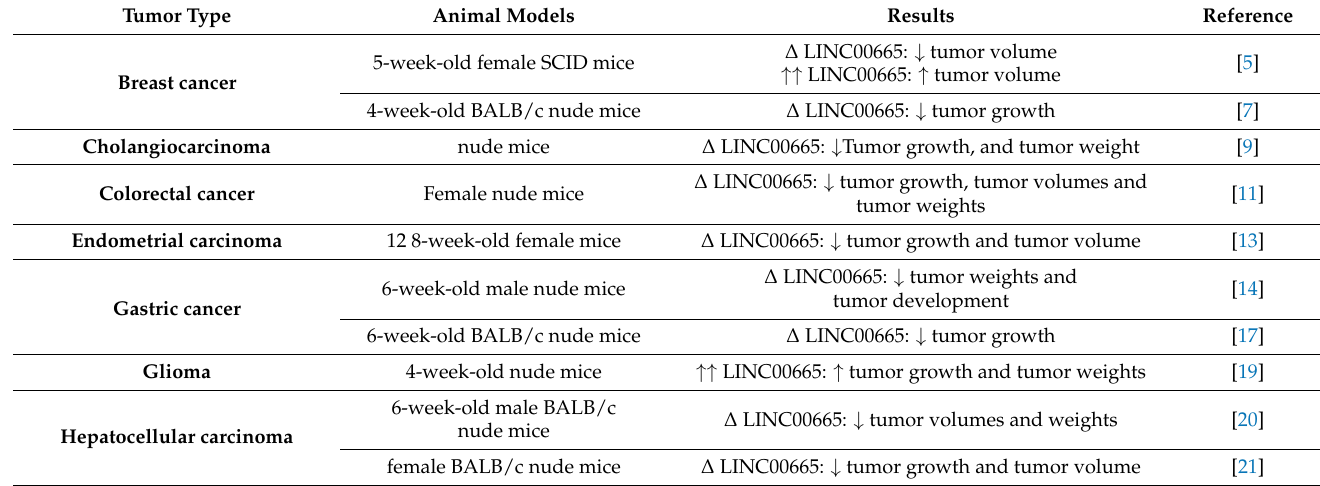
Table 2. LINC00665 function in the carcinogenesis based on studies in animal models ( ∆ : knock-down or deletion).